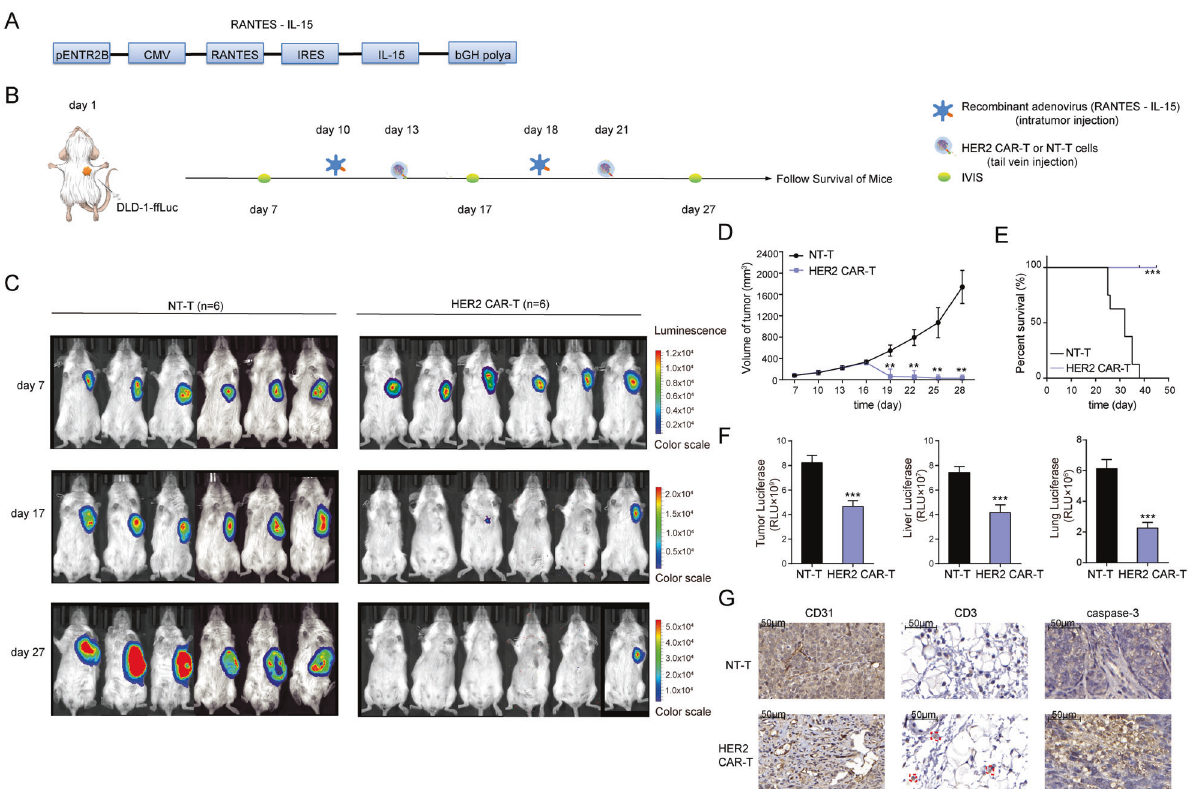
Fig. 4 HER2 CAR-T cells exhibit antitumor activity in CRC xenograft models. A Structure of recombinant adenovirus overexpressing RANTES-IL-15. B Schematic of the xenograft models ( n = 12). NCG mice were injected subcutaneously with 5 × 10 6 DLD-1-ffLuc on day 1, followed by injection of recombinant adenovirus on days 10 and 18. HER2 CAR-T or NT-T cells (1 × 10 7 ) were injected via tail vein on days 13 and 21, respectively. C IVIS followed by DLD-1-ffLuc injection, on days 7, 17, and 27, and the representative images are shown. D The volume of tumors was measured twice a week (** P < 0.01, compared with NT-T, two-tailed t -test). E KM analysis of the overall survival of mice. (*** P < 0.001, compared with NT-T, Log-rank test). F Flank tumor, liver, and lung metastatic burden in mice (*** P < 0.001, compared with NT-T of each sub-group, two-tailed t -test). G The protein levels of CD31, CD3, and caspase-3 in mice were evaluated by IHC, and the representative images are shown. The scale bar is marked in each